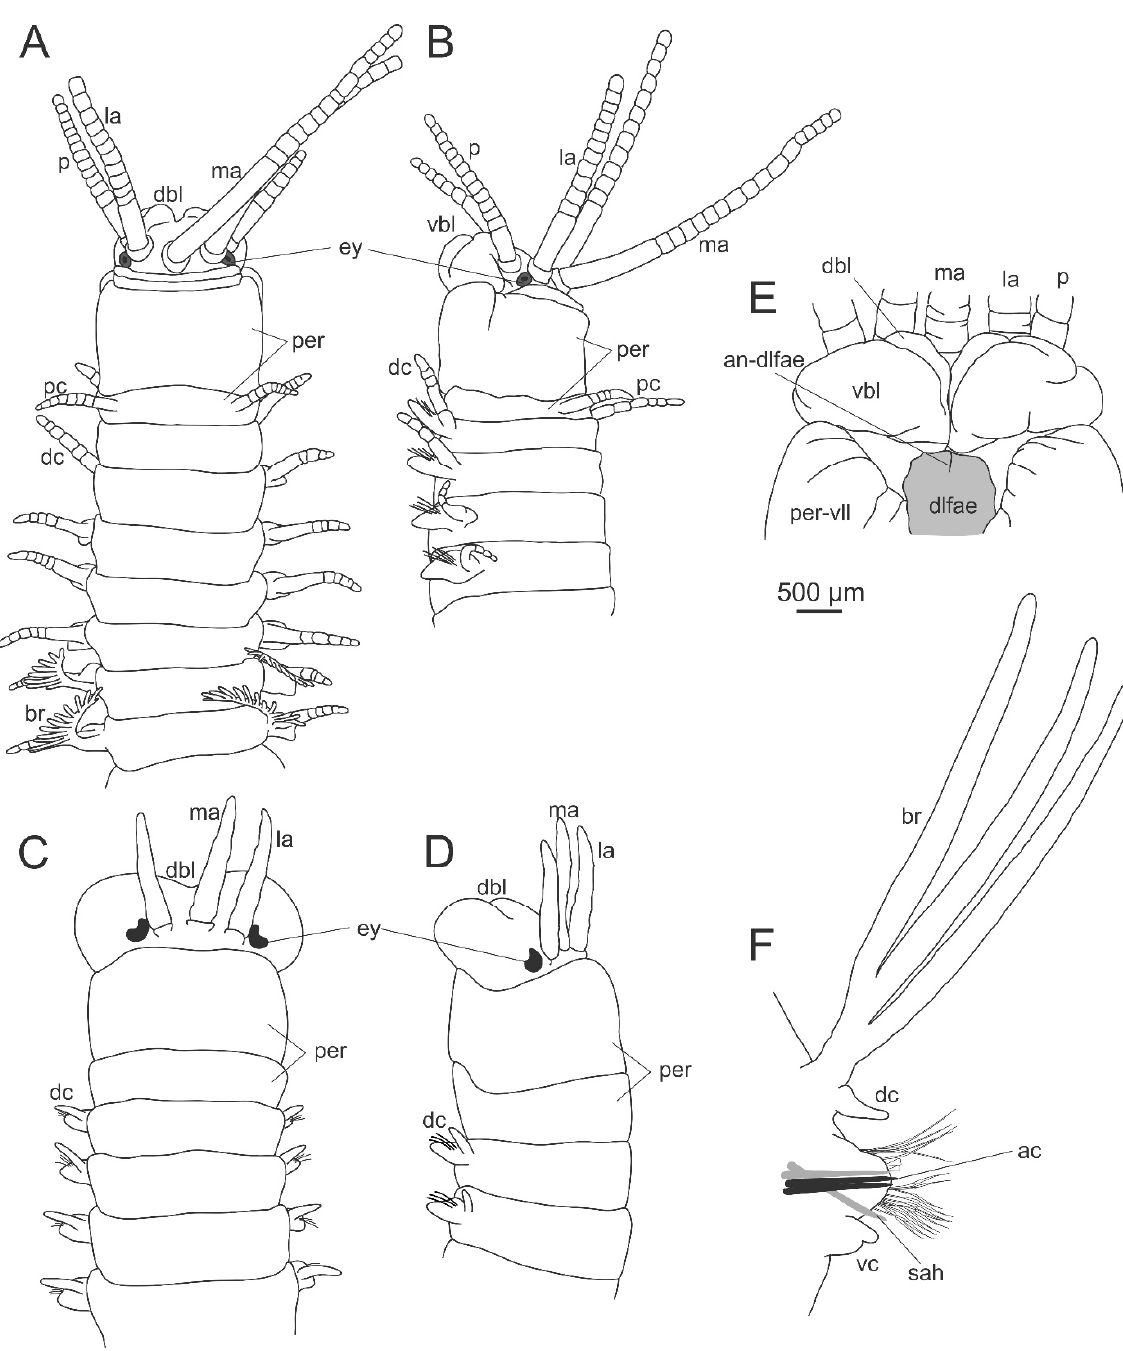
Figure 5. Morphology of Eunicidae. ( A ) Leodice sp., anterior end, dorsal view; ( B ) the same, lateral view; ( C ) Lysidice sp., anterior end, dorsal view; ( D ) the same, lateral view; ( E ) Eunice violaceomaculata Ehlers, 1887, prostomium, ventral view, dissected; ( F ) Marphysa sp., midbody parapodium. ac—acicula, an-dlfae—anterior notch of the dorsolateral fold anterior extension, br—branchia, dbl—dorsal buccal lip, dc—dorsal cirrus, dlfae—dorsolateral fold anterior extension, la—lateral antenna, ma—median antenna, p—palp, pc—peristomial cirrus, per—peristomium, per-vll—peristomial ventrolateral lips, sah—subacicular hook, vbl—ventral buccal lip, vc—ventral cirrus.